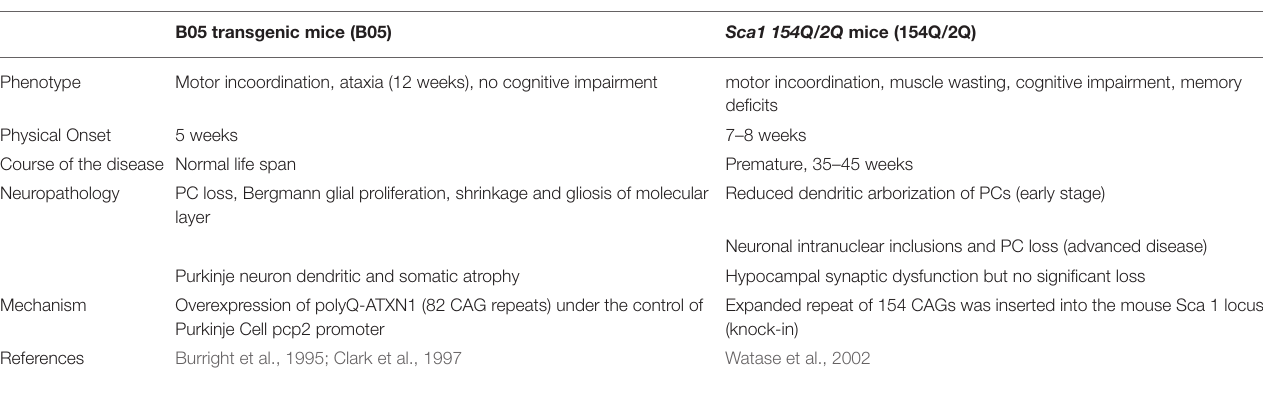
TABLE 2 | Overview of mouse models for SCA